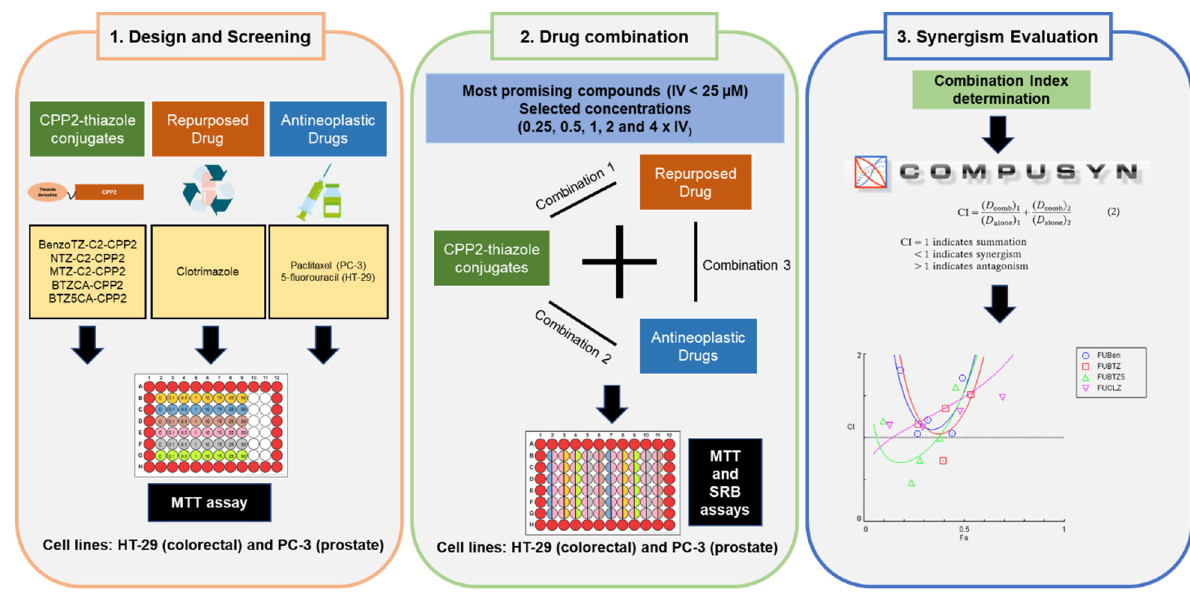
Figure 1. Representation of the study design.